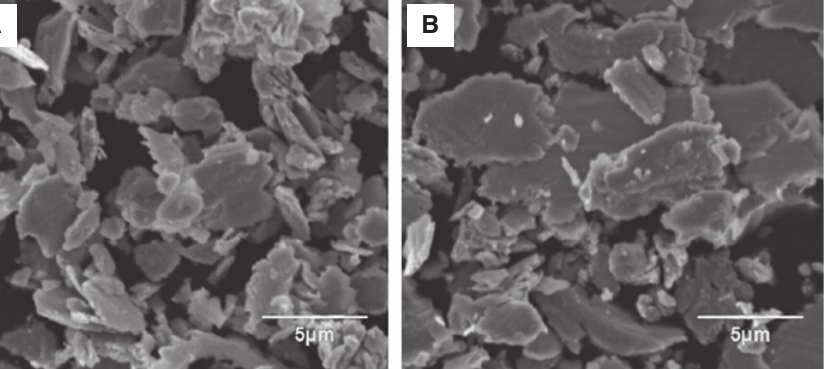
-graphite-multi-wall WS nanotubes (Cu-WS -G-WSNTs) 2 2 2